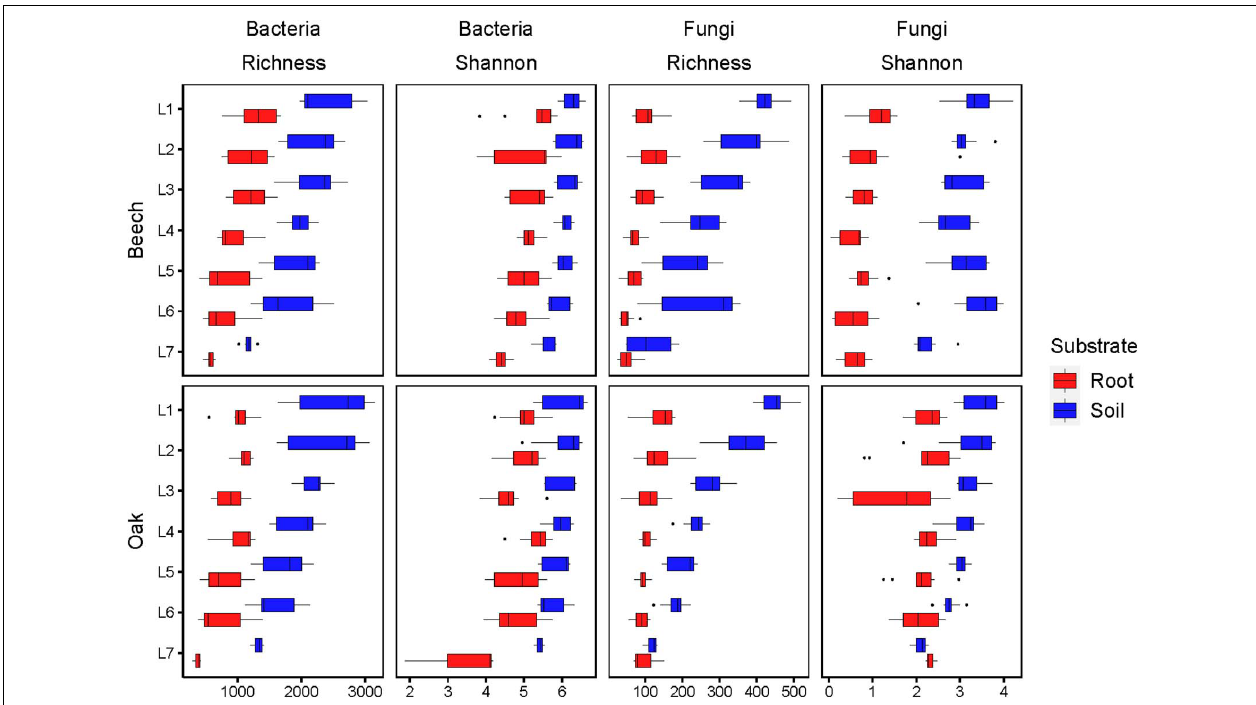
FIGURE 1 | Richness and Shannon index of bacteria and fungi of soils and fine roots in the various soil layers (L1–L7) at beech and oak sites. Soil layers: L1: 0–10 cm, L2: 15–25 cm, L3: 45–55 cm, L4: 75–85 cm, L5: 110–125 cm, L6: 140–155 cm, L7: 180–200